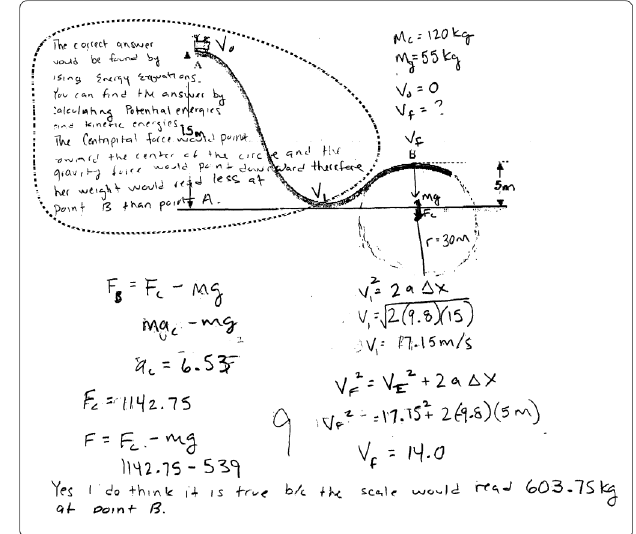
FIG. 8. Pre problem solution and self-diagnosis by a student in group D. Mistakes are (a) use of kinematics instead of energy conservation (EC), (b) wrong signs in Newton’s 2nd law. In the self-diagnosis, the student (a) refers to the fact that she had used kinematics instead of EC, and describes in words how EC should have been applied.